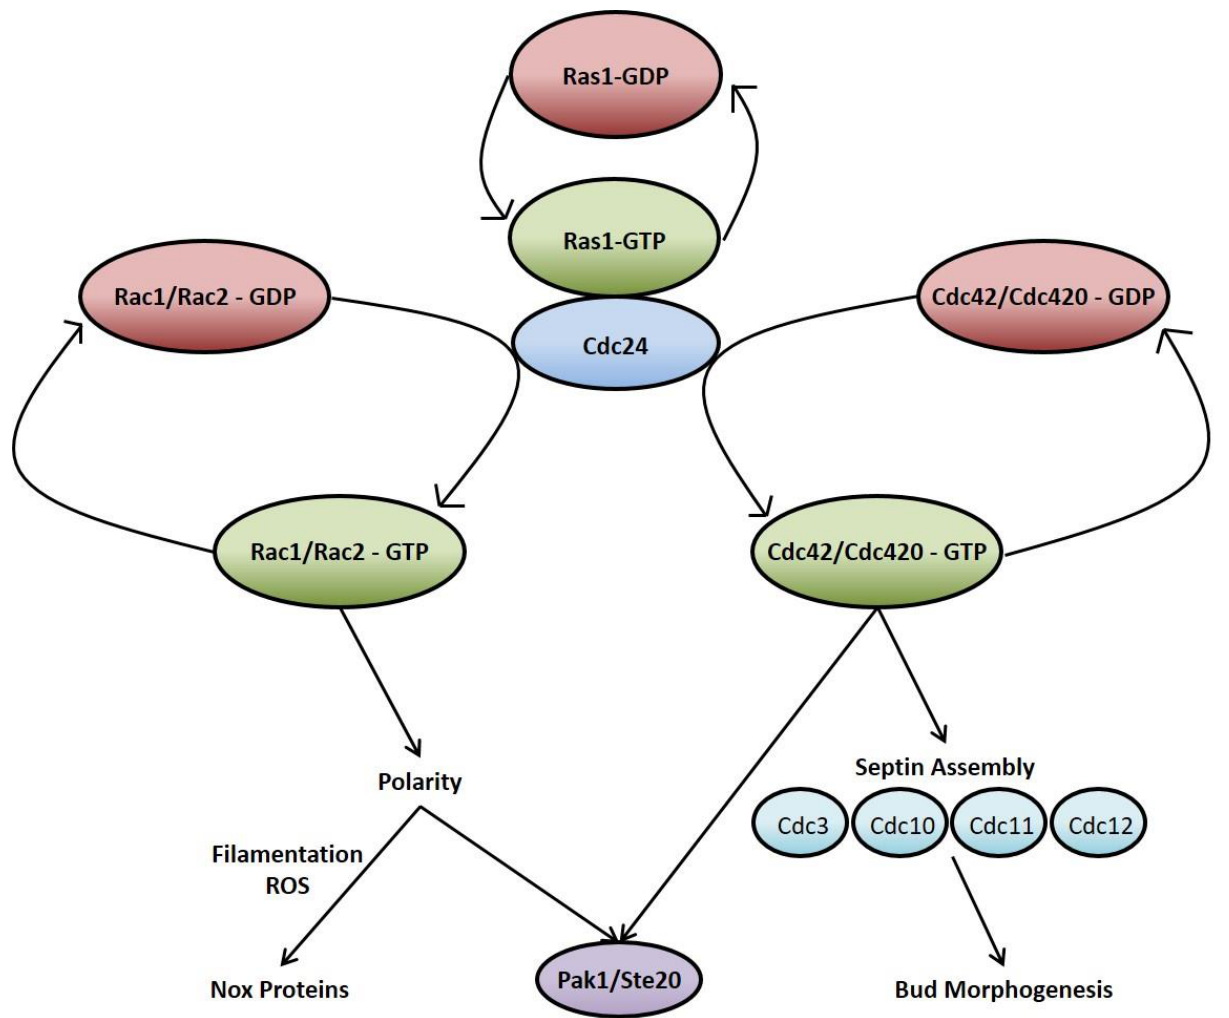
FIGURE 2: Ras1 signals via Cdc42 and Rac proteins to regulate many processes within the C. neoformans cell. Upon activation Ras1 associates with Cdc24 and subsequently activates the Rho-type GTPases Rac1/Rac2 and Cdc42/Cdc420. These proteins are involved in multiple cellular processes such as cell cycle progression, mating and morphogenesis